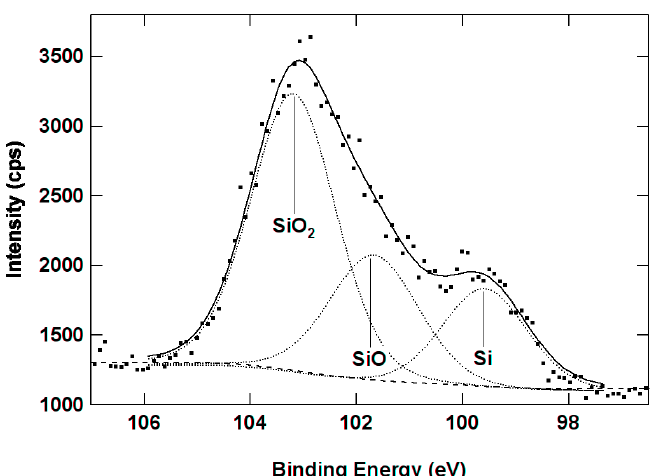
Figure 22. Typical XPS spectrum of a SiO x film fitted with three Gaussians corresponding to Si bonded as in elemental Si, SiO (mixture of suboxides), and SiO 2 . Figure